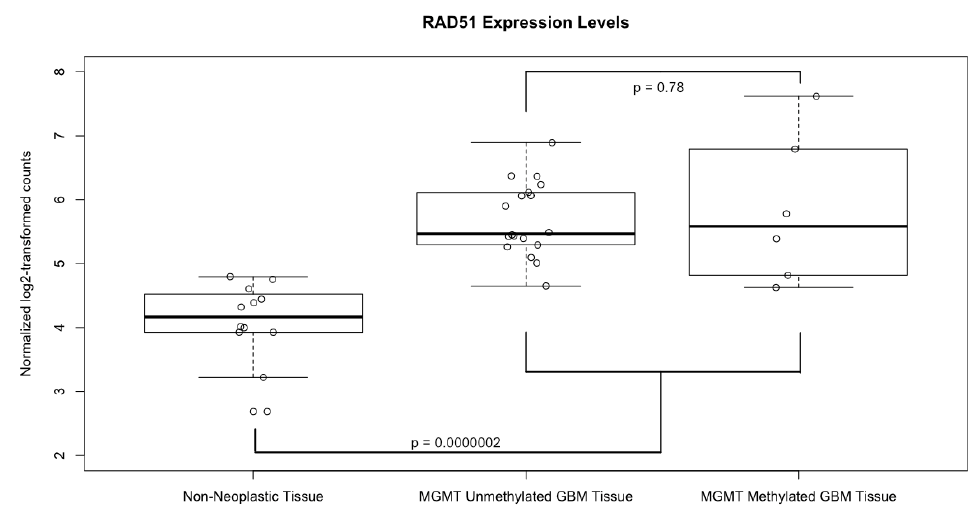
Figure 3. Expression levels of RAD51. Boxplot comparing the normalized, log2 transformed, RAD51 expression levels between GBM tissue samples, both MGMT methylated and unmethylated, and non-neoplastic controls. Solid horizontal lines represent the median value of each group; boxes show interquartile range (25–75th percentiles), while whiskers show the range of values contained within 1.5 times the interquartile range. Values from each individual sample are superimposed as hollow circles.